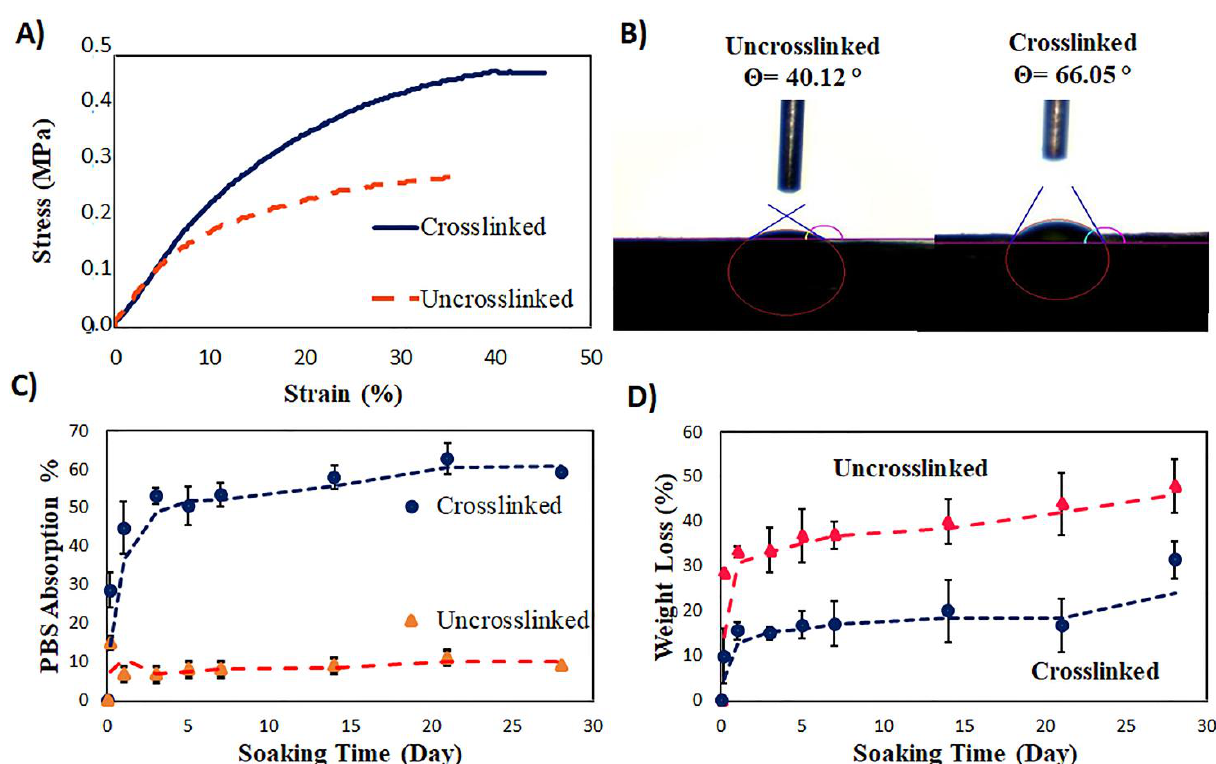
Figure 2. The mechanical and physical characterizations; ( A ) the tensile stress – strain curve; ( B ) the images of the water contact angle test; ( C ) the PBS absorption (%); ( D ) the weight loss (%) of the coaxial scaffolds before and after crosslinking. Table 2. The tensile modulus, strength, and elongation at break of the core – shell scaffold before and after crosslinking.